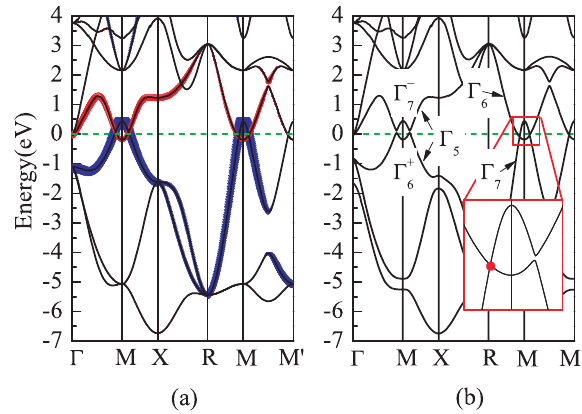
Fig. 2 a Electronic structure of CaTe without SOC. The weights of Te- 5 p z (Ca-3 d z 2 ) state is proportional to the width of blue ( red ) curves. b Electronic structure of CaTe with SOC. Along the Γ − M , M − X , and M − M ′ , a small gap is opened. The Dirac point at the M − R line is protected by the C 4 rotational symmetry. The inset is the detailed structure around the M point (see main text for detailed